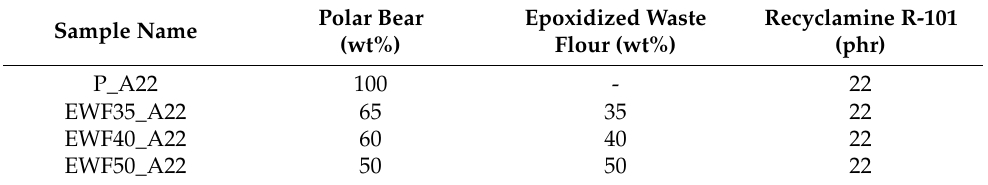
Table 1. Samples at different commercial/epoxidized waste flour ratios and constant amine content.